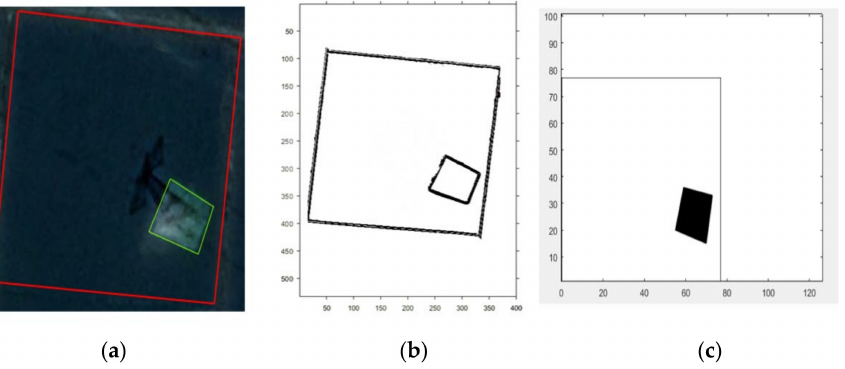
Figure 9. ( a ) Farmland map. ( b ) map after binarization. ( c ) coordinate mapping to ( b ). The red square is the boundary of the farmland area, and the green square is the boundary of the